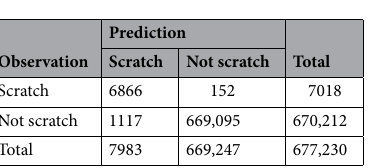
Figure 3. The result of CRNN training. ( a ) The example of CRNN output interpretation. A segment whose CRNN output was more than 0.5 was classified as scratching segment. ( b ) The number of true positive/negative segments and false positive/negative segments in the training dataset. ( c ) The number of true positive/negative segments and false positive/negative segments in the test dataset. ( d ) The comparison of scratching counts in each video file between prediction and observation in the training dataset. ( e ) The comparison of duration time of each scratching event between prediction and observation in the training dataset. ( f ) The comparison of scratching counts in each video file between prediction and observation in the test dataset. ( g ) The comparison of duration time of each scratching event between prediction and observation in the test dataset. Significantly deviated event was indicated as arrow (see Fig. 4d). The dotted lines indicate the line when prediction was equal to observation.